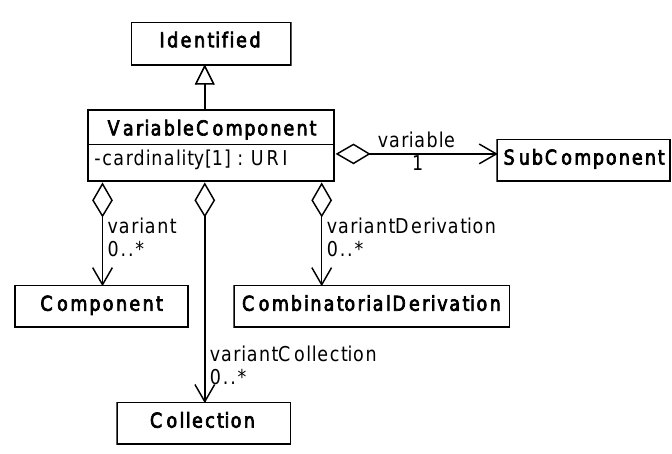
Figure 16: Diagram of the VariableComponent class and its associated